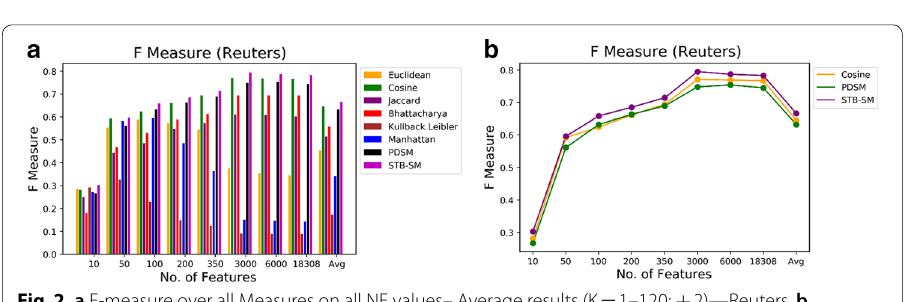
Fig. 2 a F-measure over all Measures on all NF values– Average results (K F-measure over competitive measures on all NF values–Average results (K